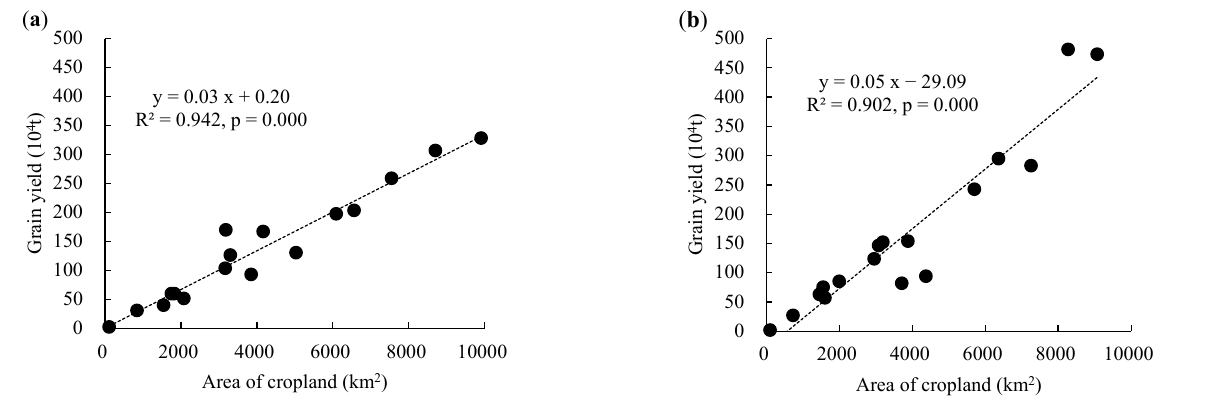
Figure 8. The relationship between grain yield and cropland area in different cities in 2000 ( a ) and 2018 ( b ).